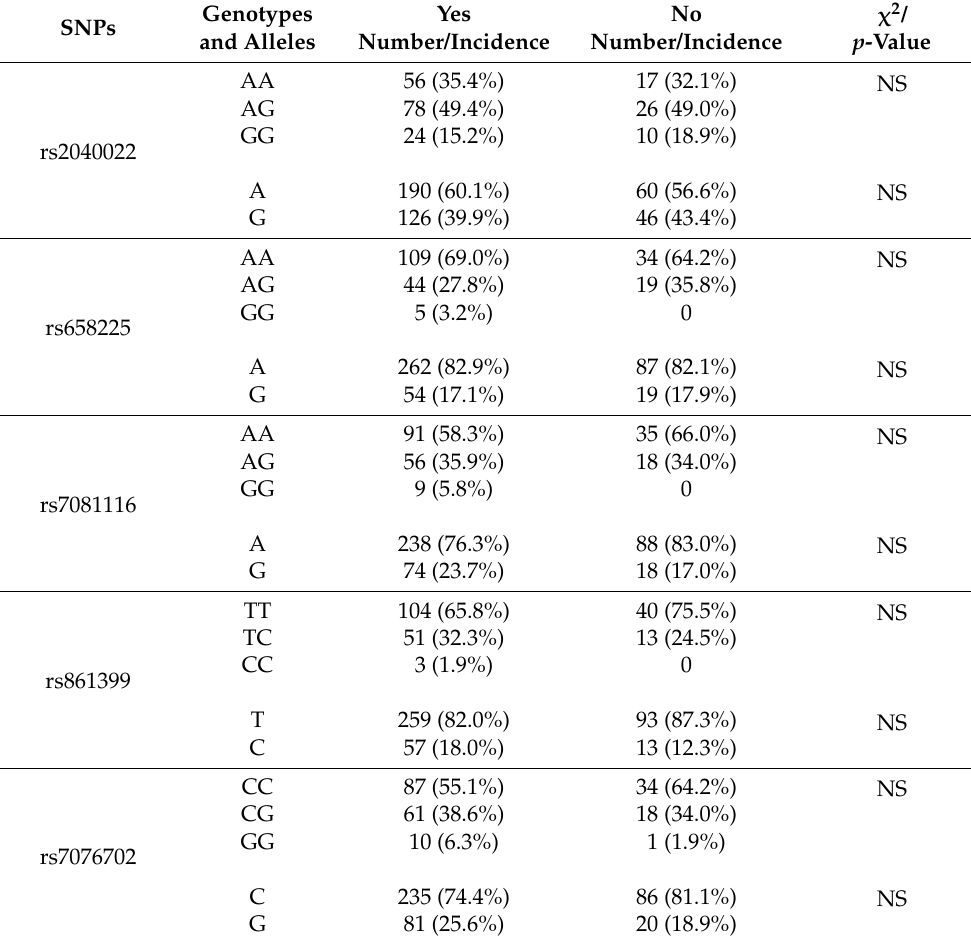
Table 8. Genotype and allele frequencies of the HPSE2 gene SNPs in correlation with bone morbidity in multiple myeloma